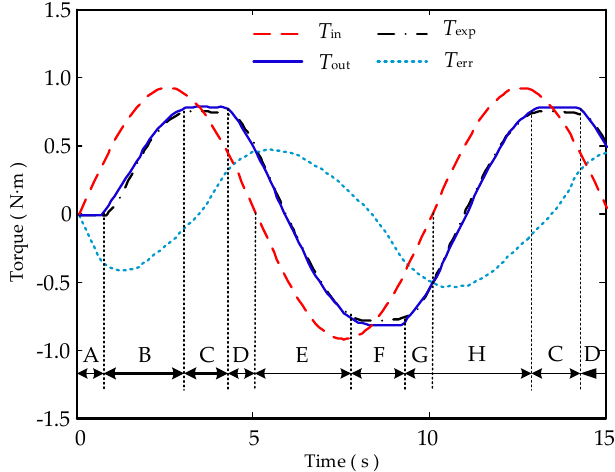
Figure 4. Model analysis of the double tendon-sheath torque transfer characteristics.